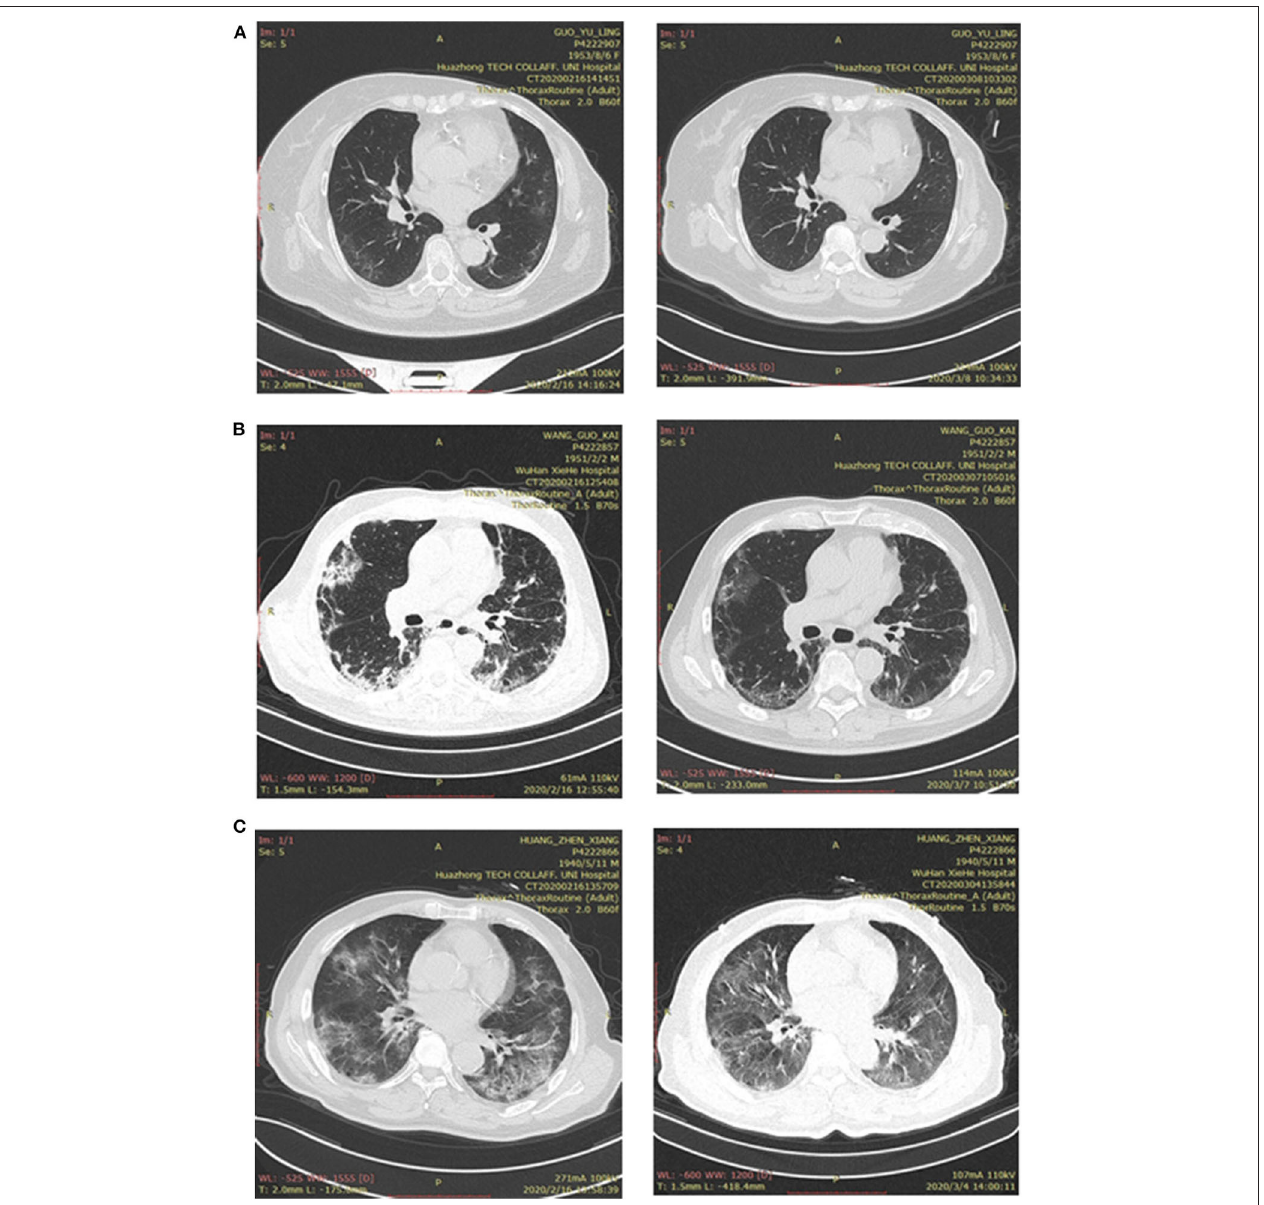
FIGURE 1 | (A) Bilateral pneumonia in a patient with breast cancer. (Left side) Chest CT, showing bilateral ground-glass opacity, was performed on admission; (right side) CT was performed after treatment for COVID-19. (B) Bilateral pneumonia in a patient without cancer. (Left side) Chest CT, showing bilateral patchy shadowing, was performed on admission; (right side) CT was performed after treatment for COVID-19. (C) Bilateral pneumonia in a patient with other types of cancer. (Left side) Chest CT, showing bilateral ground-glass opacity, was performed on admission; (right side) CT was performed after treatment for COVID-19.